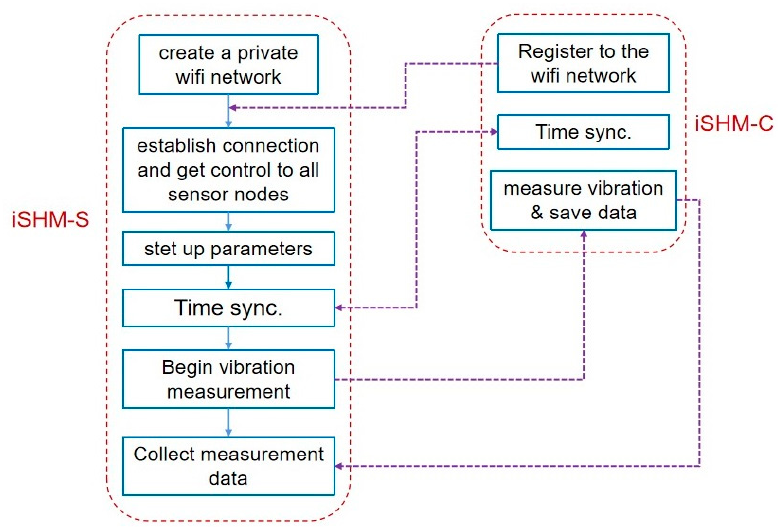
Figure 3. Operation procedure of iSHM-S and iSHM-C.